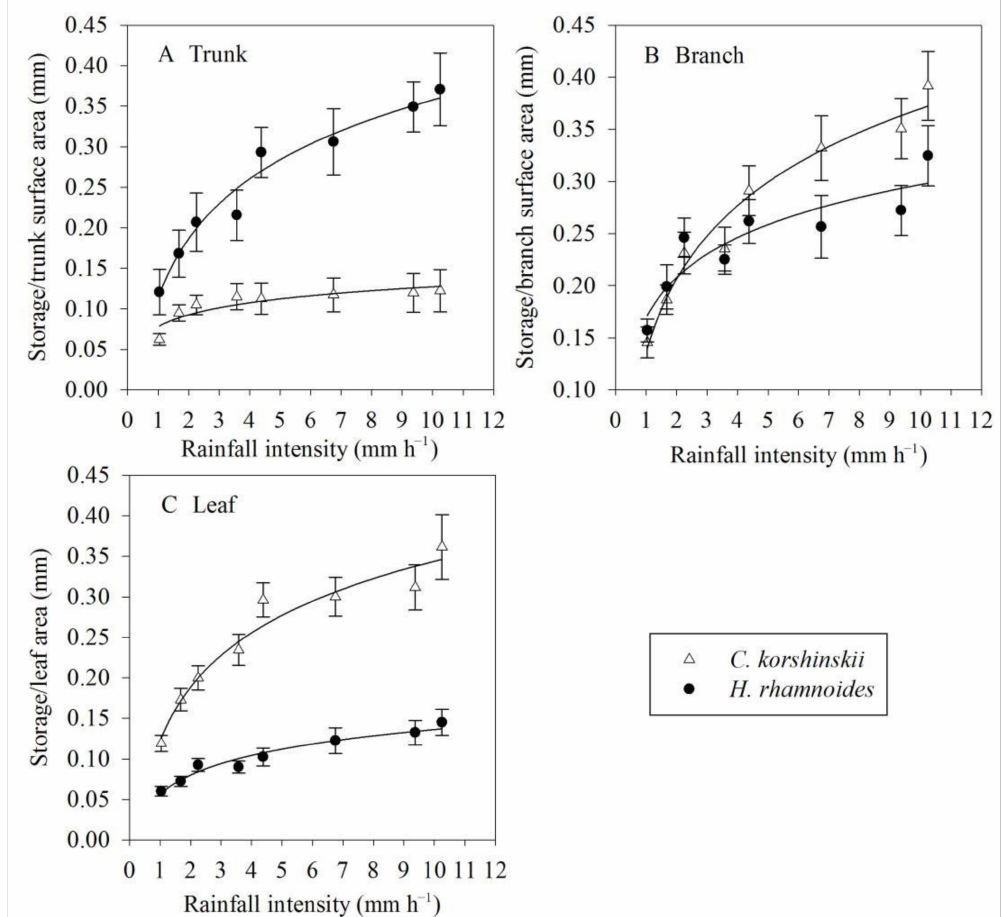
Figure 7. Canopy storage capacity per trunk, branch, and leaf area for eight rainfall intensities for C. korshinskii and H. rhamnoides . Values are the average of the equilibrium stores in all tests for each species ( n = 16). The vertical bars show the standard error. ( A ), Trunk; ( B ), Branch; ( C ), Leaf.